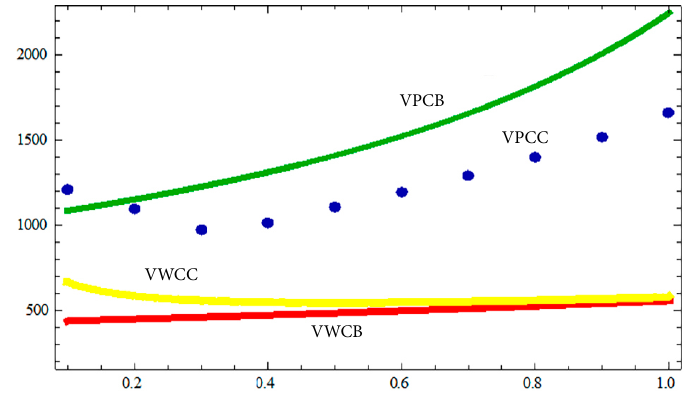
Figure 2. Comparison of cluster